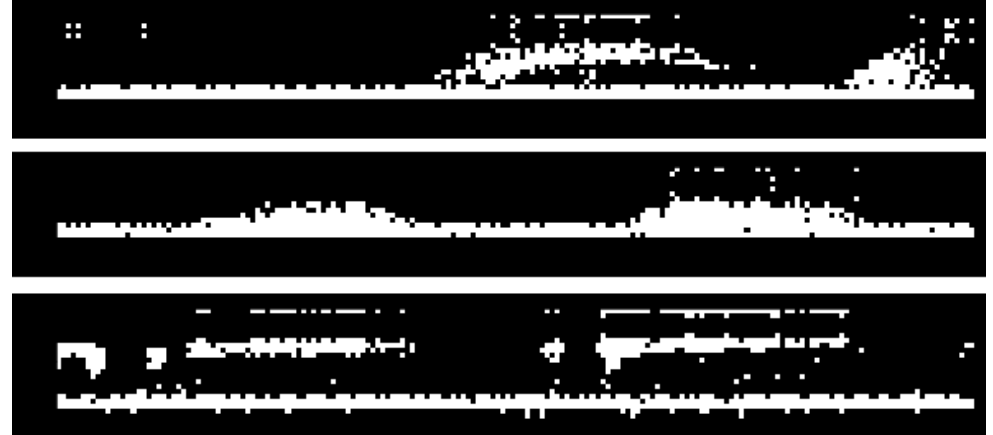
Figure 3. Data from Figure 1 after undergoing a db5 wavelet transform.